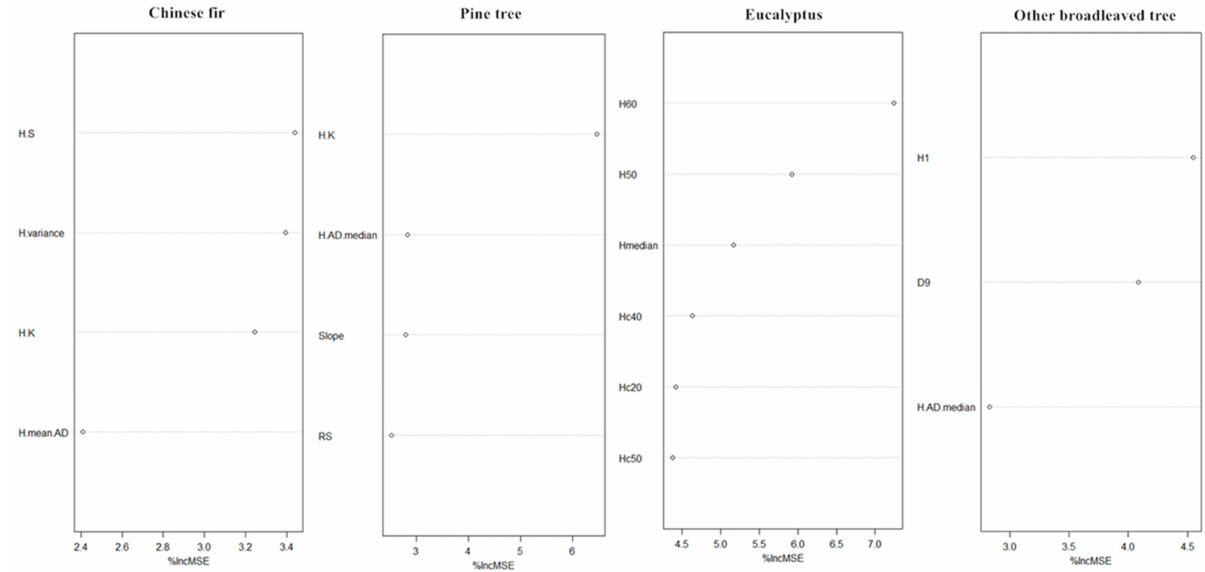
Figure 3. Map of feature importance